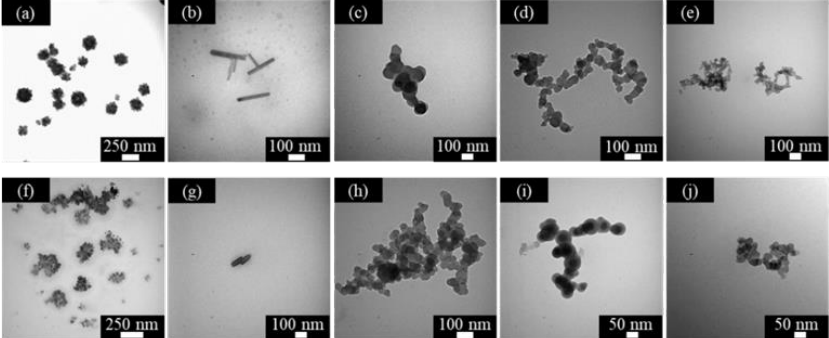
Figure 5. TEM images of DPD at different concentrations and pH values—pH = 1.42: ( a ) 2 CMC and ( f ) 5 CMC; pH = 3.04: ( b ) 2 CMC and ( g ) 5 CMC; pH = 6.04: ( c ) 2 CMC and ( h ) 5 CMC; pH = 9.06: ( d ) 2 CMC and ( i ) 5CMC; pH = 10.08: ( e ) 2 CMC and ( j ) 5CMC.